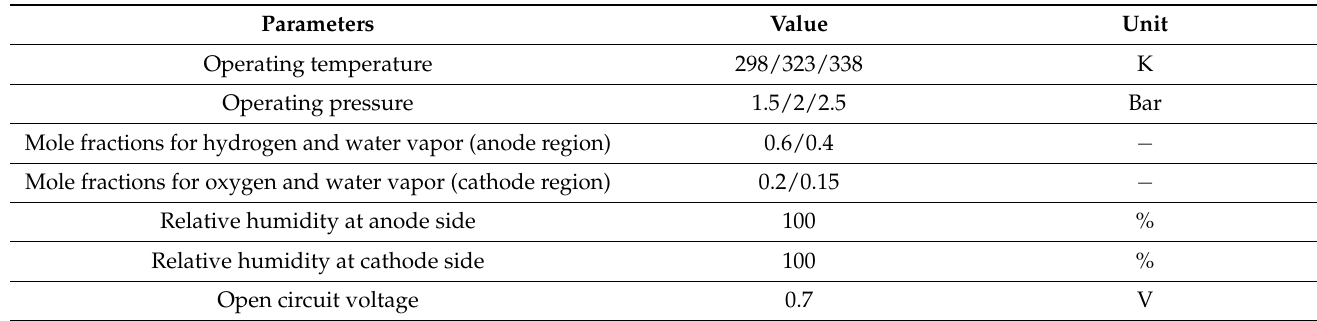
Table 2. Parameters for